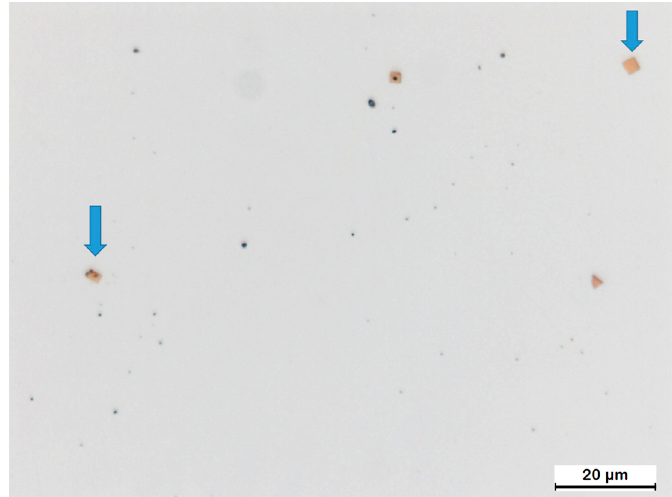
Figure 2. Examples of the large precipitates observed by optical microscopy in the Ti10Nb3 steel quenched after reheating for initial microstructural analysis .